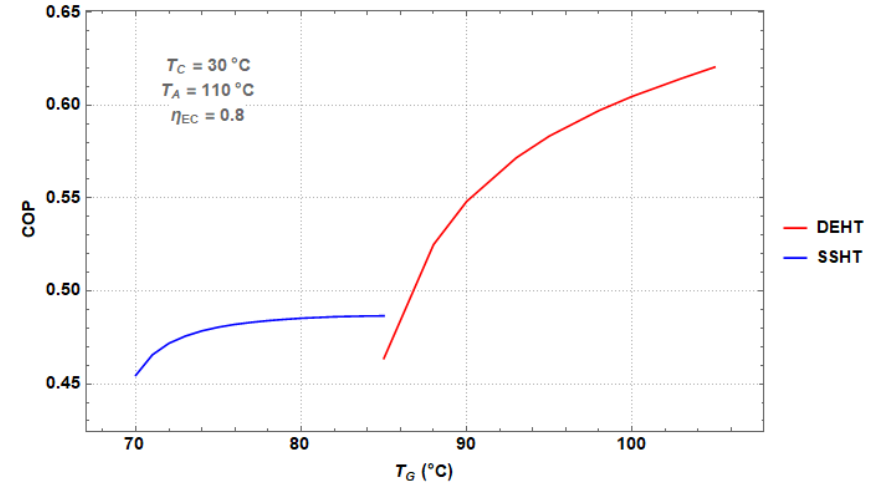
ff erent heat transformers. G for the two di